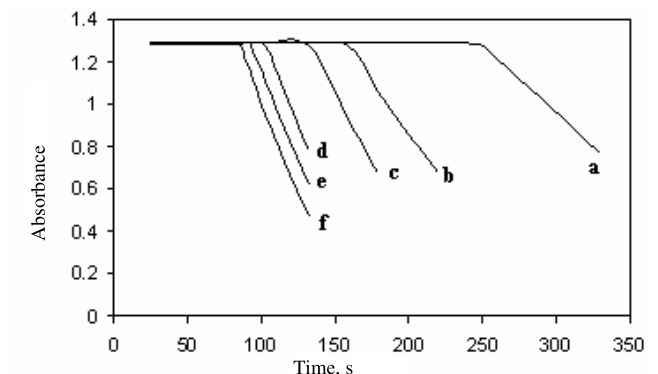
Figure 3. Change in absorbance of 10 mg L -1 methyl orange solution over time in the presence of 0.35 mol L -1 HCl, 7.9 × 10 -5 mol L -1 iodide and (a) 3.9 × 10 -4 ; (b) 5.2 × 10 -4 ;